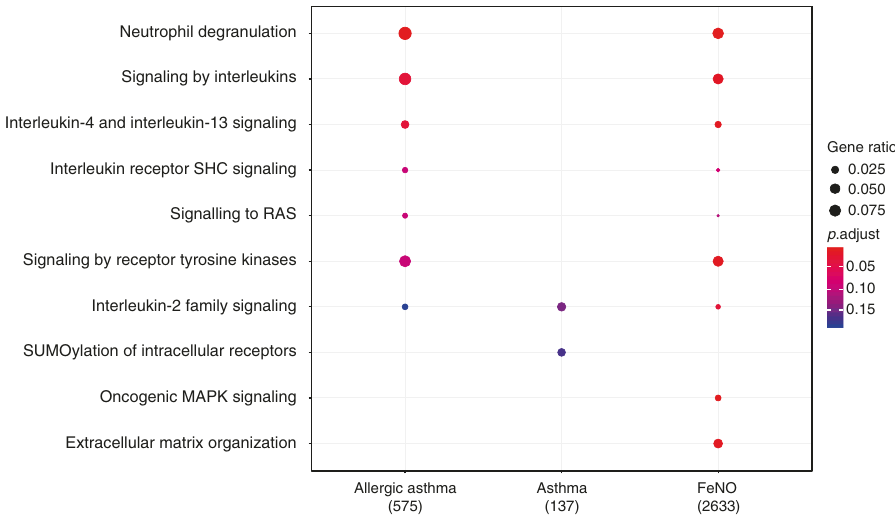
Fig. 3 Differentially methylated gene ontology categories. Gene enrichment analyses for gene ontologies present in the Reactome database that were differentially methylated in epigenome-wide association analyses (false discovery rate (FDR) < 0.05) for allergic asthma, asthma, and fractional exhaled nitric oxide